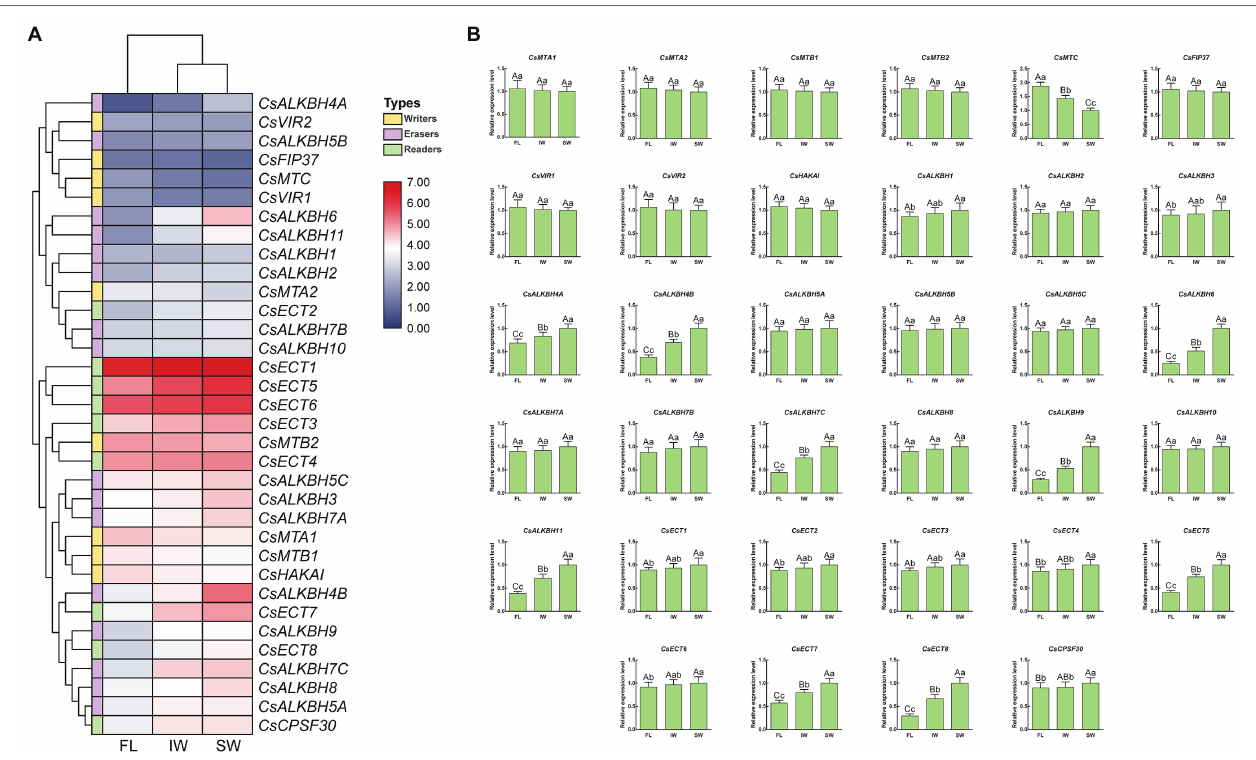
FIGURE 10 | Expression patterns of m6A regulatory genes during tea-withering. (A) The heat map of m6A regulatory genes during tea-withering based on the transcriptome data. The expression values of m6A regulatory genes were normalized by log 2 -transformed (FPKM + 1). (B) Expression patterns of m6A regulatory genes during tea-withering determined by qRT-PCR. Data are presented as mean ± SD. Lowercase letter indicates significant difference ( p < 0.05); uppercase letter indicates highly significant difference ( p < 0.01). FL: fresh leaves; IW: indoor-withered leaves; SW: solar-withered leaves. Public transcriptome data were collected from the NCBI Sequence Read Archive (SRA) database under accession number PRJNA562623. The freshly apical buds with first leaves were picked uniformly from eight-year-old tea plants ( C. sinensis cv. Tieguanyin) at the development stage of one bud with three leaves. The picked leaves were evenly divided into three parts. The first part was collected immediately as the FL. The second part was exposed to sunlight for 45 min. The third part was subjected to indoor-withering for 45 min. The FL, IW, and SW were sampled, respectively. Each sample was performed in three independent biological replicates.